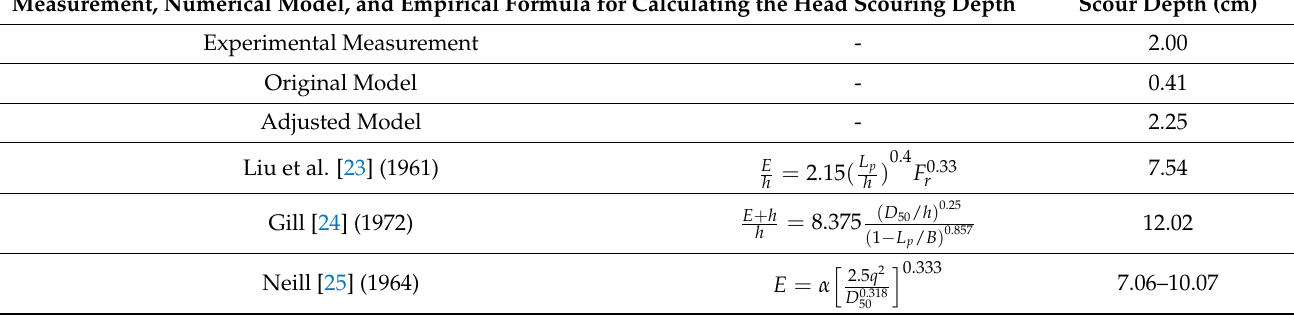
Table 5. Comparison of the experiment, numerical model, and empirical formula results. Measurement, Numerical Model, and Empirical Formula for Calculating the Head Scouring Depth Scour Depth (cm) Experimental Measurement - 2.00 Original Model -